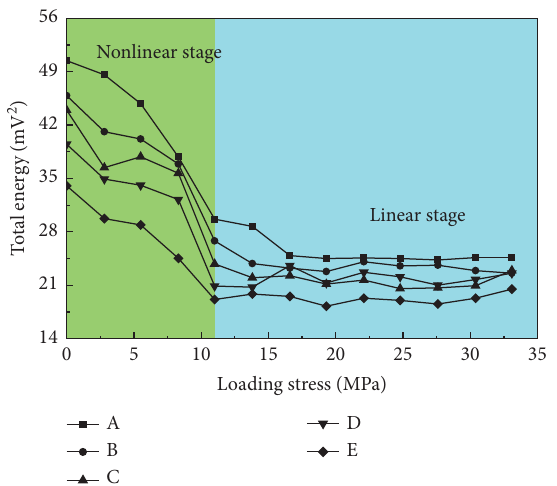
Figure 8: Variation tendency of total energy with the increase of loading